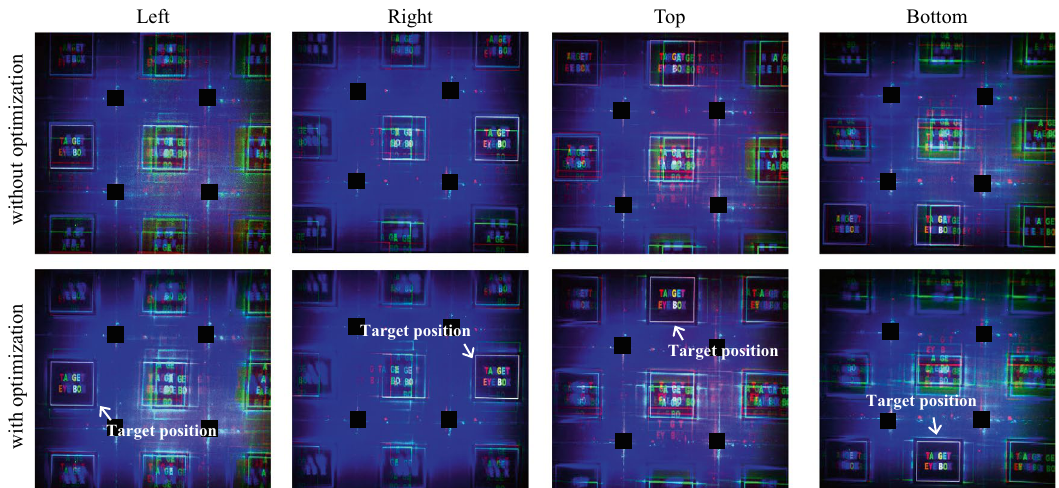
Figure 3. Reconstructed Fourier holograms from the non-optimized and optimized CGH for the left, right, top, and bottom position on the eyebox plane.